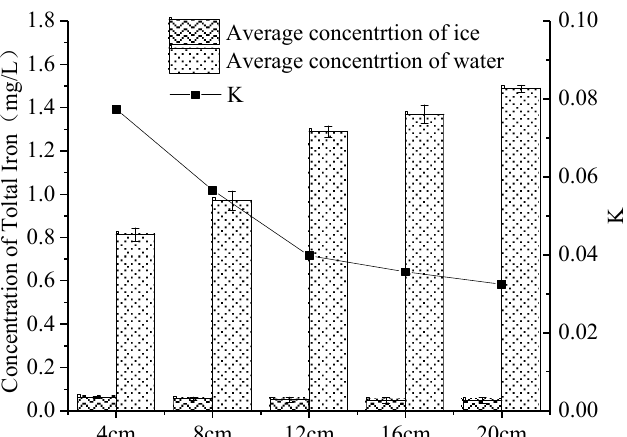
Figure 6. Distribution of iron of varying icing thicknesses in the ice–water system. (Error bar: Mean ± S.D., K: the ratio of the average concentration of iron in the ice to that in the under ‐ ice water).